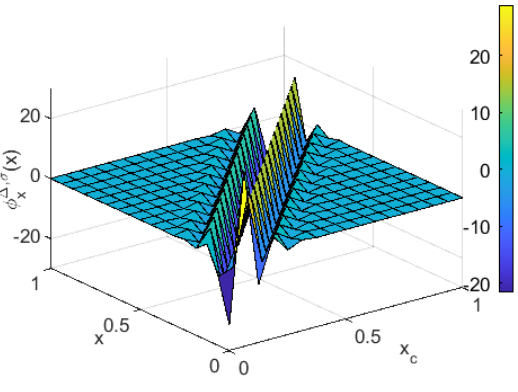
Figure 3. The first-order derivative of the quasi-Shannon scaling function on the interval [ 0,1 ]